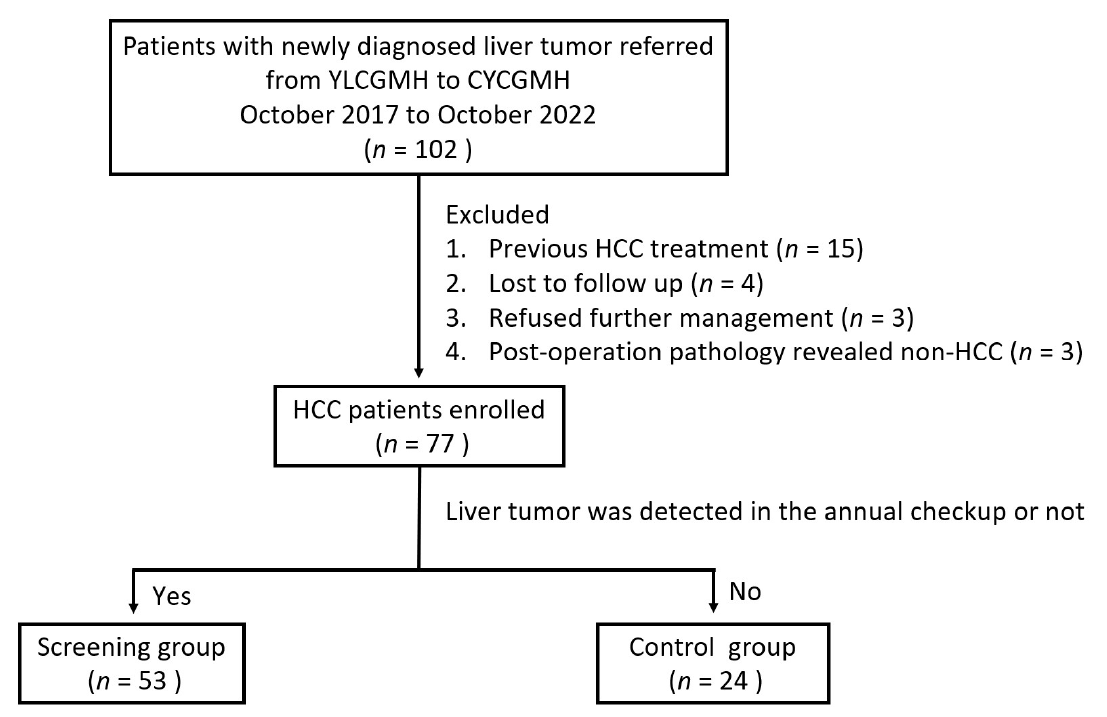
Figure 2. Patient enrollment flow diagram.